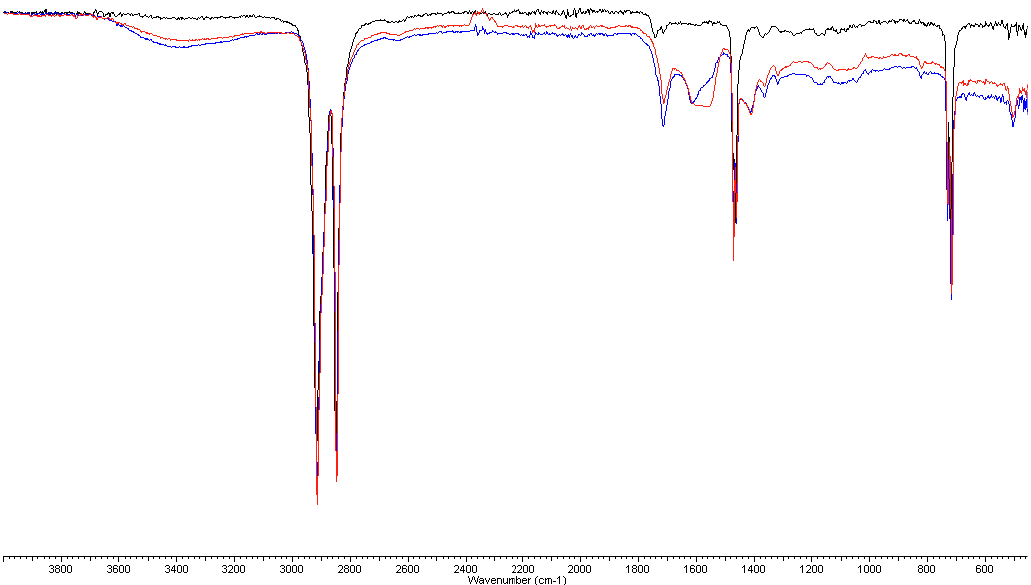
Figure 4. FT-IR spectra of PERT inner surface: new ( black ), 4 weeks ( red ), and 8 weeks ( blue Figure 4 . FT-IR spectra of PERT inner surface: new (black), 4 weeks (red), and 8 weeks (blue) .